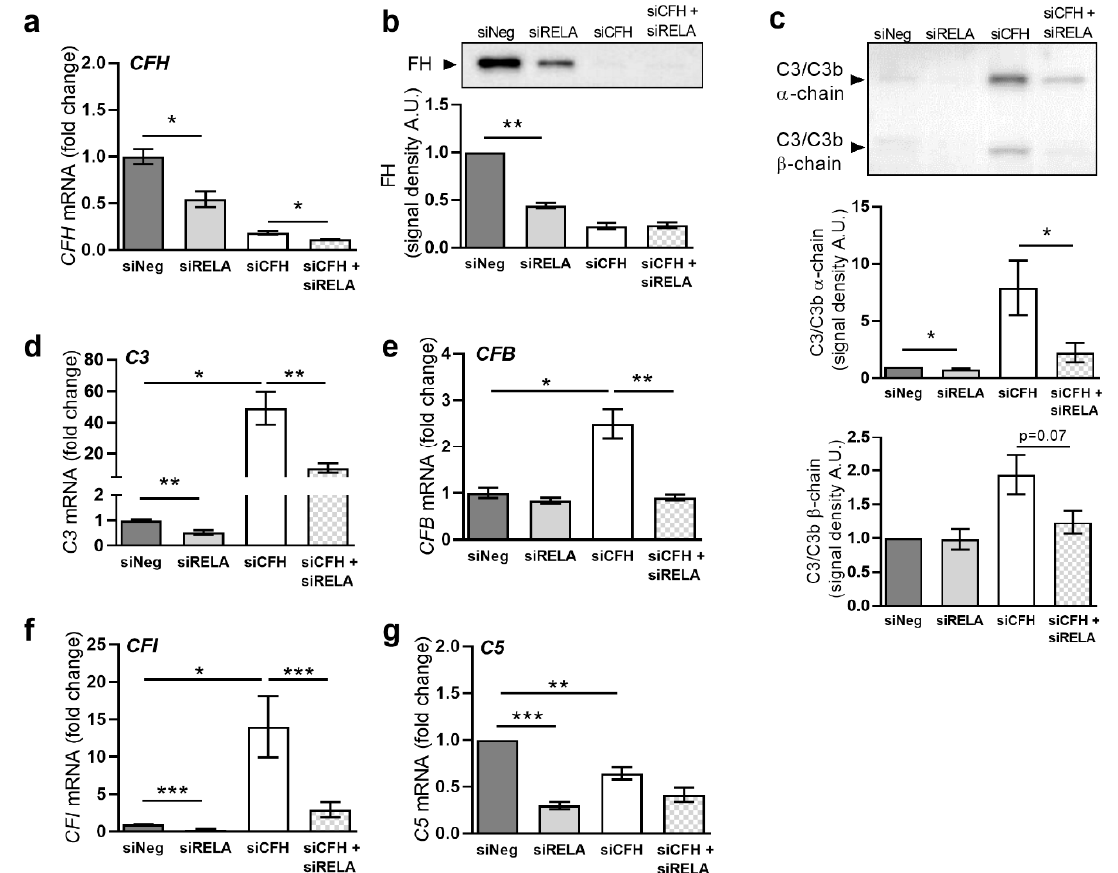
Figure 4. FH loss alters gene transcription of complement system genes via the NF- κ B pathway. ( a ) Evaluation of CFH expression by qRT-PCR analyses. Data are normalized to the housekeeping gene PRPL0 using ∆ ∆ Ct methods. SEM is shown, n = 5. ( b ) Evaluation of C3 expression by qRT-PCR analyses. Data are normalized to the housekeeping gene PRPL0 using ∆ ∆ Ct methods. SEM is shown, n = 5. ( c ) Western blot analyses of C3 α -chain and β -chain protein levels in cell culture supernatants. Quantification of the signal density of four independent experiments is shown. ( d ) Western blot analyses of FH protein levels in cell culture supernatants. Quantification of the signal density of three independent experiments is shown. ( e ) Evaluation of CFB expression by qRT-PCR analyses. ( f ) Evaluation of CFI expression by qRT-PCR analyses. ( g ) Evaluation of C5 expression by qRT-PCR analyses. Data are normalized to the housekeeping gene PRPL0 using ∆ ∆ Ct methods. SEM is shown, n = 5. Western blot images were cropped, and full-length blots are provided in Supplementary Material. Significance was assessed by a Student’s t-test, where * p < 0.05, ** p < 0.01, *** p < 0.001. Abbreviations used include: negative control (siNeg), CFH specific siRNA (siCFH), RELA specific siRNA (siRELA).